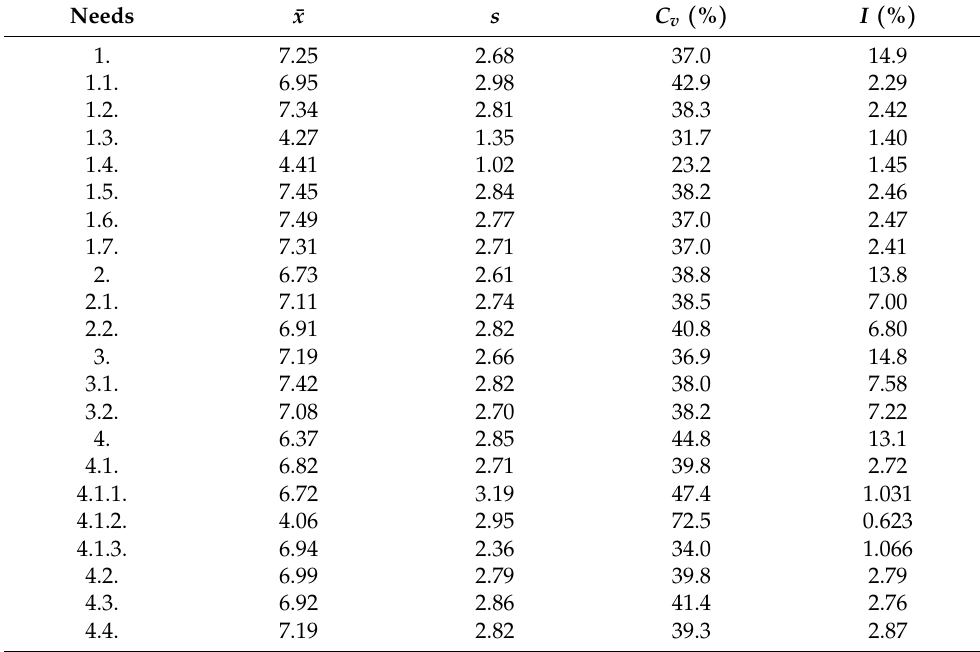
Table 3. Results for the relative importance of the needs obtained from the questionnaire.